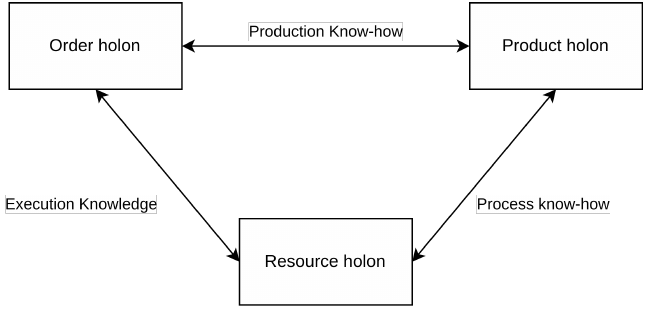
Figure 1. Relations between basic